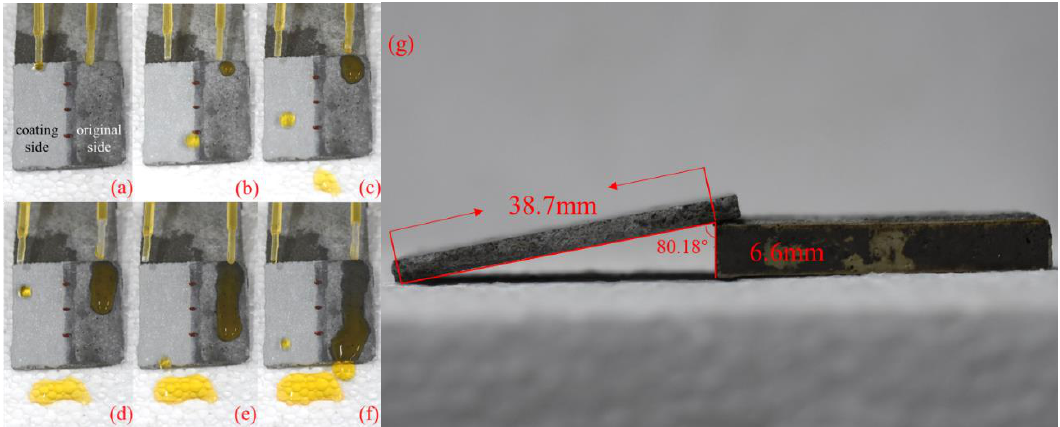
Figure 12. ( a – f ) The superhydrophobic surface holds a better drainage capacity compared to the untreated surface, ( g ) The side view of the half-coating specimen with a title angle of